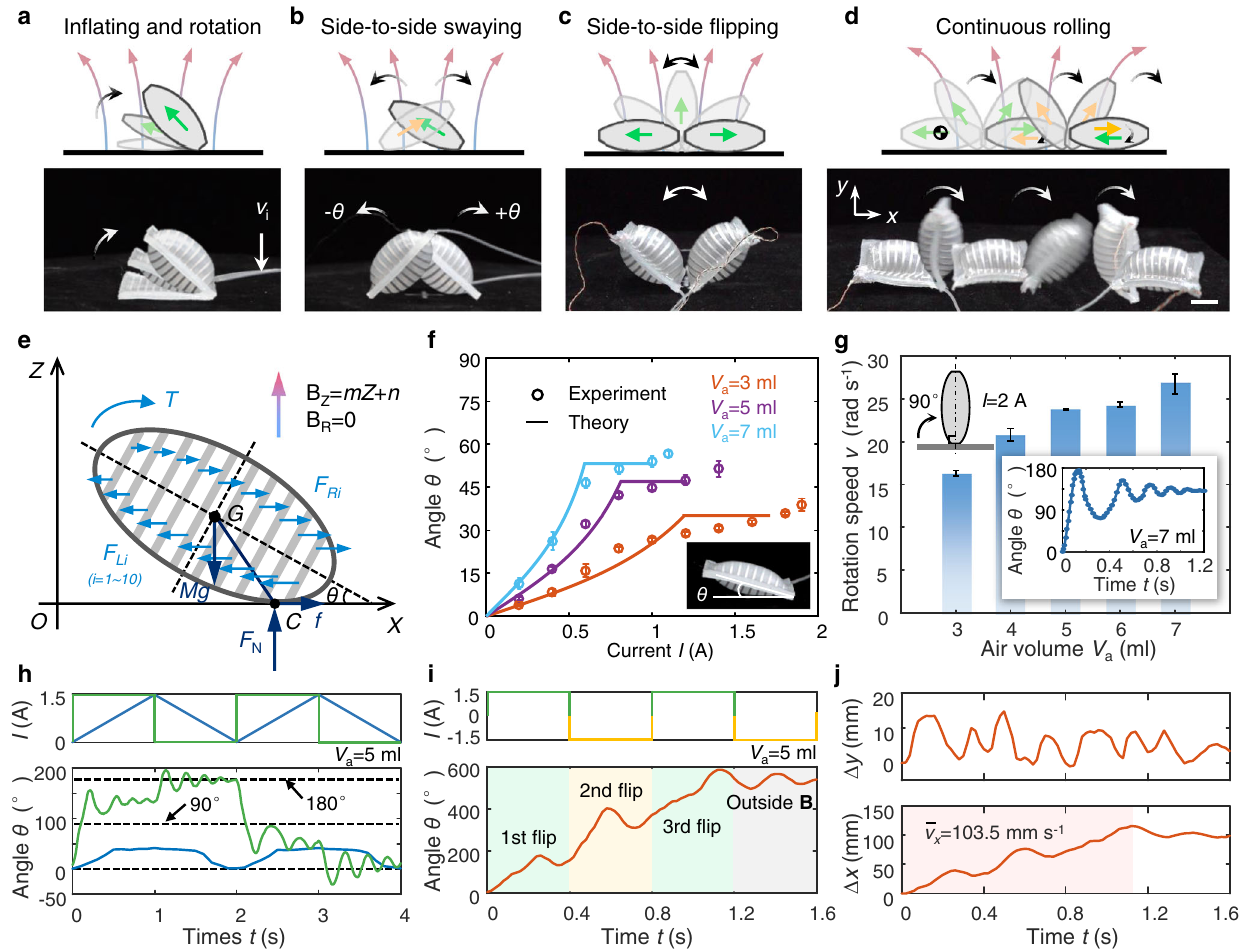
Fig. 4 | ActuationcharacterizationofthemoduleH underaconstant magnetic fi eld. a In fl ating and rotation motion ofthe modulewhen injectedwith air under a constant current. b Side-to-side swaying motionof themodule whensubject to AC triangular-wavecurrentsignals.Theclockwise rotationangleisde fi ned aspositive, whilethecounterclockwiseisnegative. c Side-to-side fl ippingmotionofthemodule when subject to unipolar square-wave signals. d Continuous rolling motion of the modulewhensubjecttobipolarsquare-wavesignals.Thecenterofmassismarked. Scale bar=10mm. e Force and motion analysis of the module H. f Comparison of theoretical and experimental results on the stable and critical rotation angle θ varying with the input current for different precharged air volume V a . Error bars